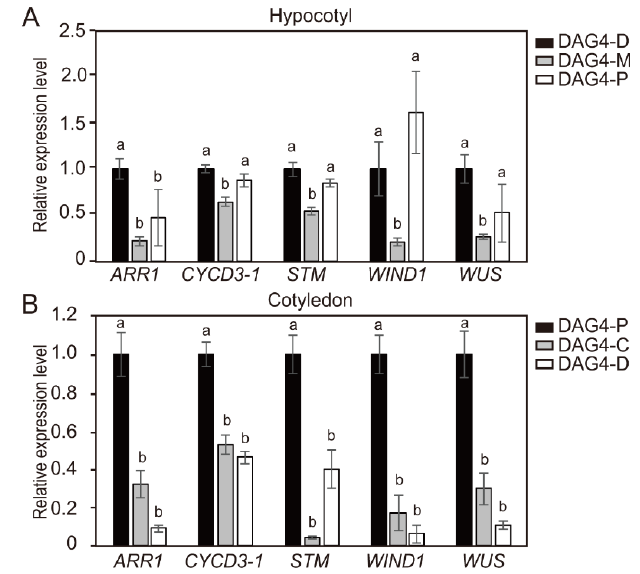
Figure 6. The relative expression levels of CYCD3-1 and shoot regeneration regulatory genes in hypocotyl and cotyledon explants excised from in vitro-grown seedlings in di ff erent positions. ( A ) The relative gene expression levels of ARR1 , CYCD3-1 , STM, WIND1 , and WUS in distal (D), middle (M), and proximal (P) positions of DAG4 seedling hypocotyl explants. ( B ) The relative gene expression levels of ARR1, CYCD3-1 , STM , WIND1 , and WUS in proximal (P), middle (M), and distal (D) positions of DAG4 seedling cotyledon explants. Three independent experiments were performed. Error bars represent SD ( n = 3). Di ff erent letters in each gene indicate statistically significant di ff erences the three DAG groups (AVOVA followed by a Turkey’s test, p < 0.05). DAG = day after germination.